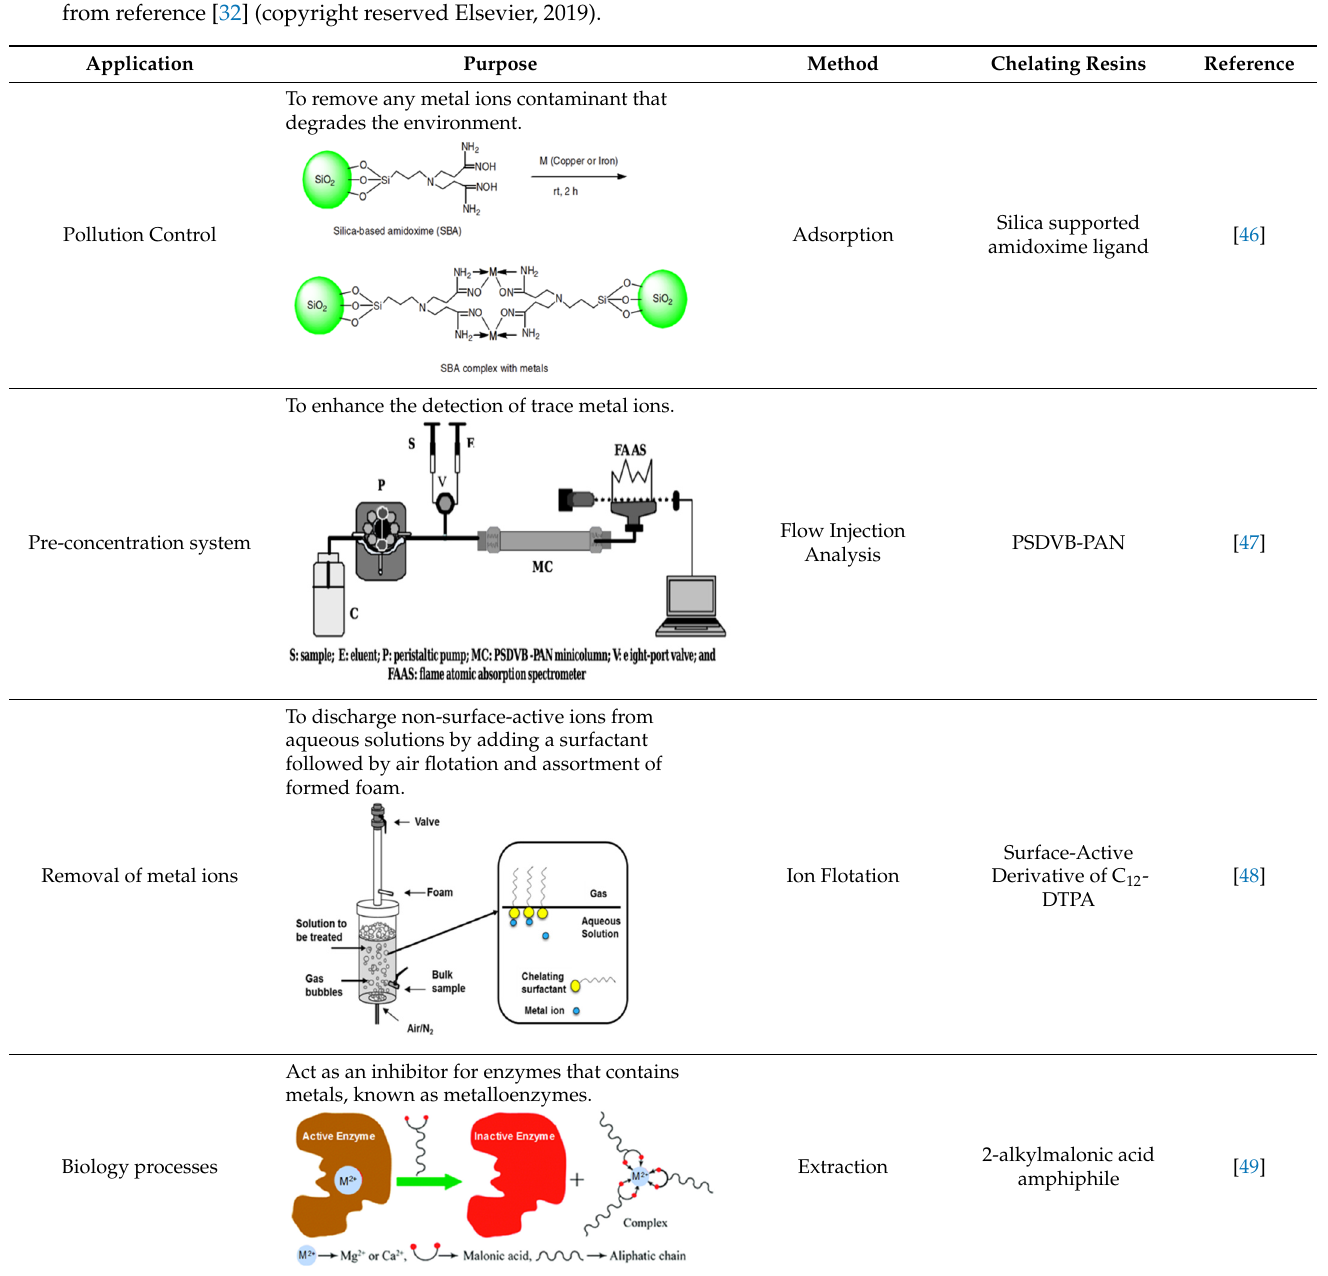
Table 9. Lists of adsorbent classification. Adopted from reference [34] (copyright reserved Elsevier, 2018). Adopted from reference [50] (copyright reserved Elsevier, 2021). Adsorbent